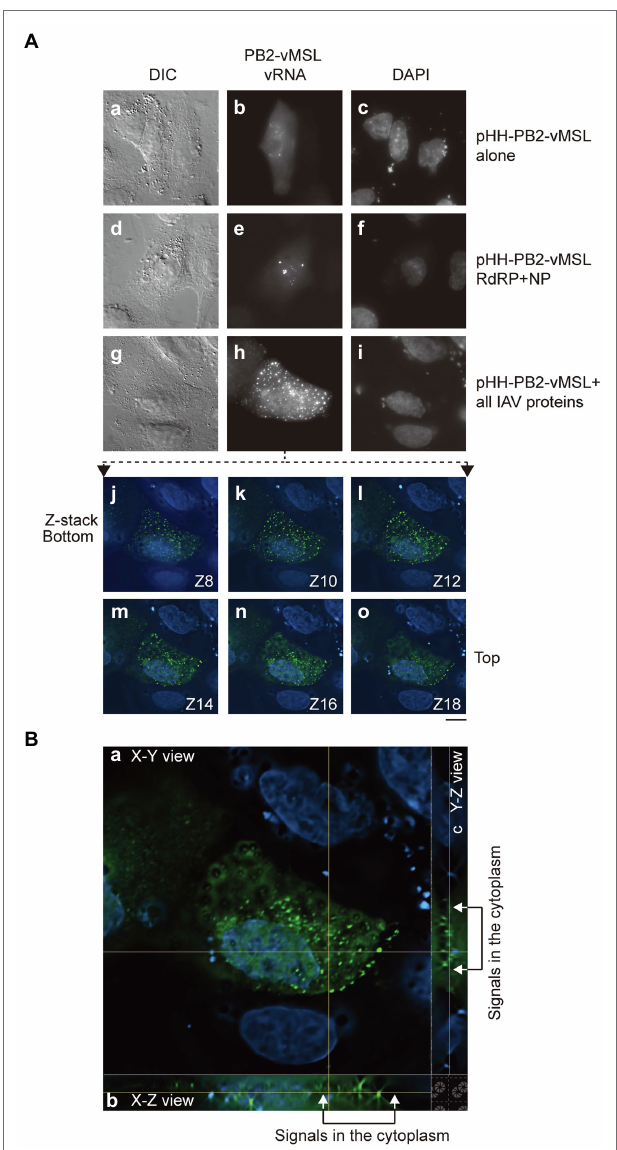
FIGURE 2 | Distribution of PB2-vMSL vRNA punctate signals in A549 cells. (A) A549 cells were co-transfected with (a–c) pHH-PB2-vMSL and pMCP- GFPdN; (d–f) pHH-PB2-vMSL, pMCP-GFPdN, and plasmids expressing NP and the RdRP components, PB1, PB2, and PA; or (g–i) pHH-PB2-vMSL, pMCP-GFPdN, and eight plasmids encoding all IAV proteins (pQCXIH-PB2, pDZ-PB1, pDZ-PA, pDZ-NP, pDZ-HA, pDZ-NA, pDZ-M, and pDZ-NS). The images of representative cells are shown as the square of maximum intensity projections across the z-planes in ImageJ. The signals of the representative cell (g–i) in multiple Z planes were shown (j–o) . (B) The signals in the representative cell (g–i) were deconvoluted with NIS-elements v5.2 (Nikon) and shown in orthogonal sectioning of a z-stack: (a) XY view; (b) XZ view; (c) YZ view. Cells were fixed with paraformaldehyde at 16 h post-transfection. The nucleus was stained with DAPI. Differential interference contrast (DIC) and fluorescence images were acquired using a Nikon TiE eclipse inverted microscope, using the same settings as those employed for Figure 1 . Scale bar: 10 μ